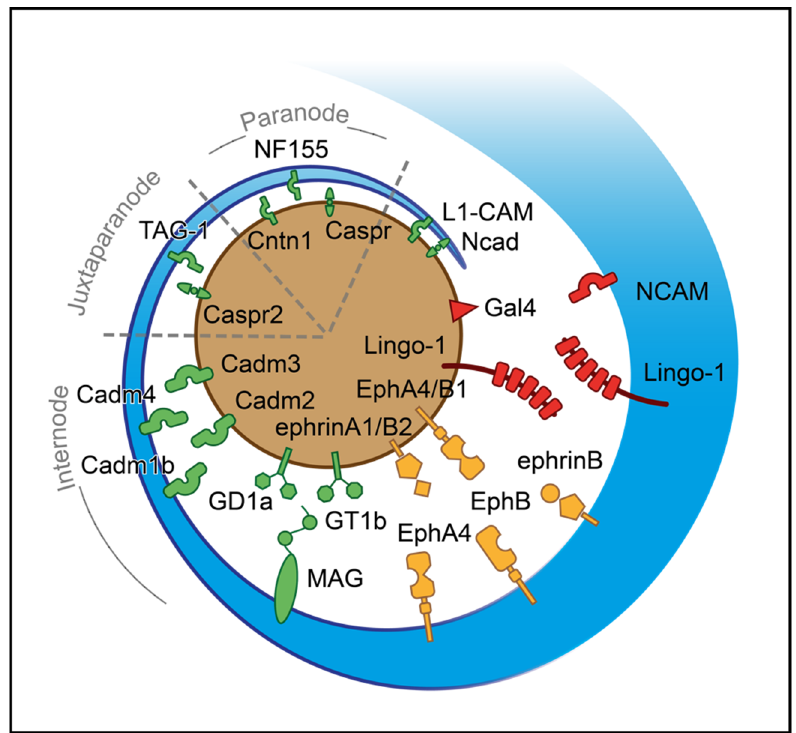
Figure 2. Axoglial driving cues for the initiation of ensheathment during myelinogenesis. A process of oligodendrocyte (blue) approaches the axon (brown) based on their surfaces’ attractive and re- pulsive signals. The red-colored shapes represent negative surface molecules; the green ones stand for positive and the yellow for bidirectional signals. For illustrational purposes, the paranode, juxtaparanode, and internode regions are simplified. CADM1b: Cell adhesion molecule 1b, CADM2: Cell adhesion molecule 2, CADM3: Cell adhesion molecule 3, CADM4: Cell adhesion molecule 4,